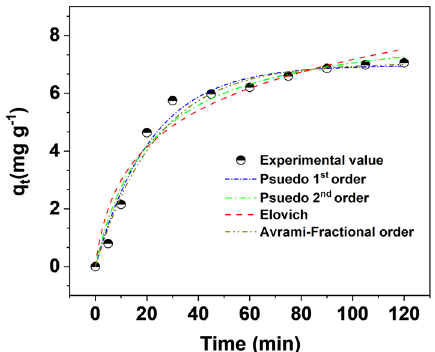
Fig. 10 The adsorption kinetics plots for the removal of 30 mg L −1